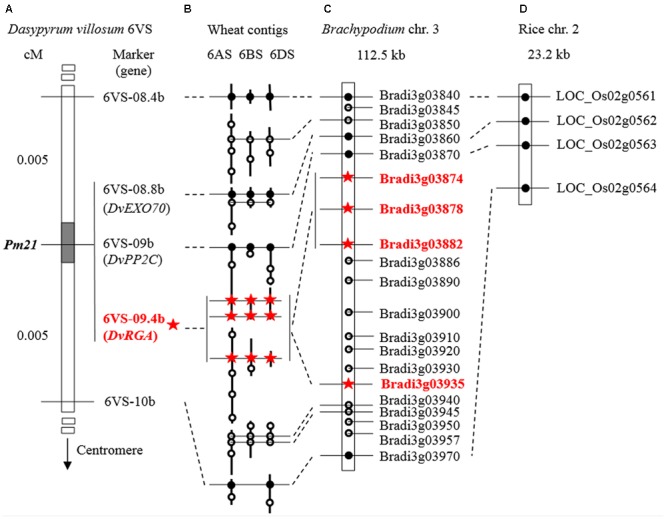
Comparative mapping of Pm21. (A) Genetic map (partial) using the F2 population derived from the cross between the resistant D. villosum line DvRes-1 and the susceptible line DvSus-1. The dark region on the chromosome 6VS demonstrates the genetic interval carrying Pm21. The vertical arrow shows the direction of the centromere of 6V. The complete genetic map can be found in Figure 3A. (B–D) Comparative maps of the Pm21 locus among D. villosum 6VS, wheat 6AS, 6BS, and 6DS (B), the short arms of Brachypodium chromosome 3 (C) and rice chromosome 2 (D). The homologous wheat contigs of genes of interest were obtained and annotated by using the BLAST, FGENESH, and SMART programs (Table 2). All genes from Brachypodium and rice are adopted according to the annotations of the corresponding genomes except the RGA Bradi3g03935 in Brachypodium that was re-annotated in this study. The solid circles and hollow circles indicate conserved genes and unconserved genes among different genomes, respectively. The orthologous RGAs among D. villosum, wheat and Brachypodium are marked by red stars.